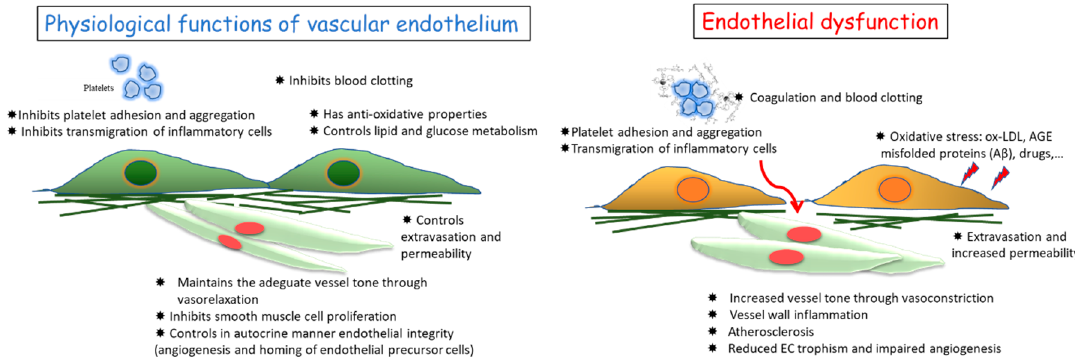
Figure 1. Features and functions of a healthy endothelium ( left panel ) and dysfunctional endothelium ( right panel ). The evolution from functional to dysfunctional endothelial cells (ECs) depends on various factors both exogenously (pollutants, toxins, drugs, diet components) and endogenously produced (oxidized lipoproteins: ox-LDL, hyperglycemia and glycation products: AGE, misfolded proteins such as beta-amyloid-A β , reactive oxygen species: ROS). Here, we have focused on the hypothesis that microbiota derived metabolites can influence endothelial behavior and thus cardiovascular disease (CVD) risk and manifestation.